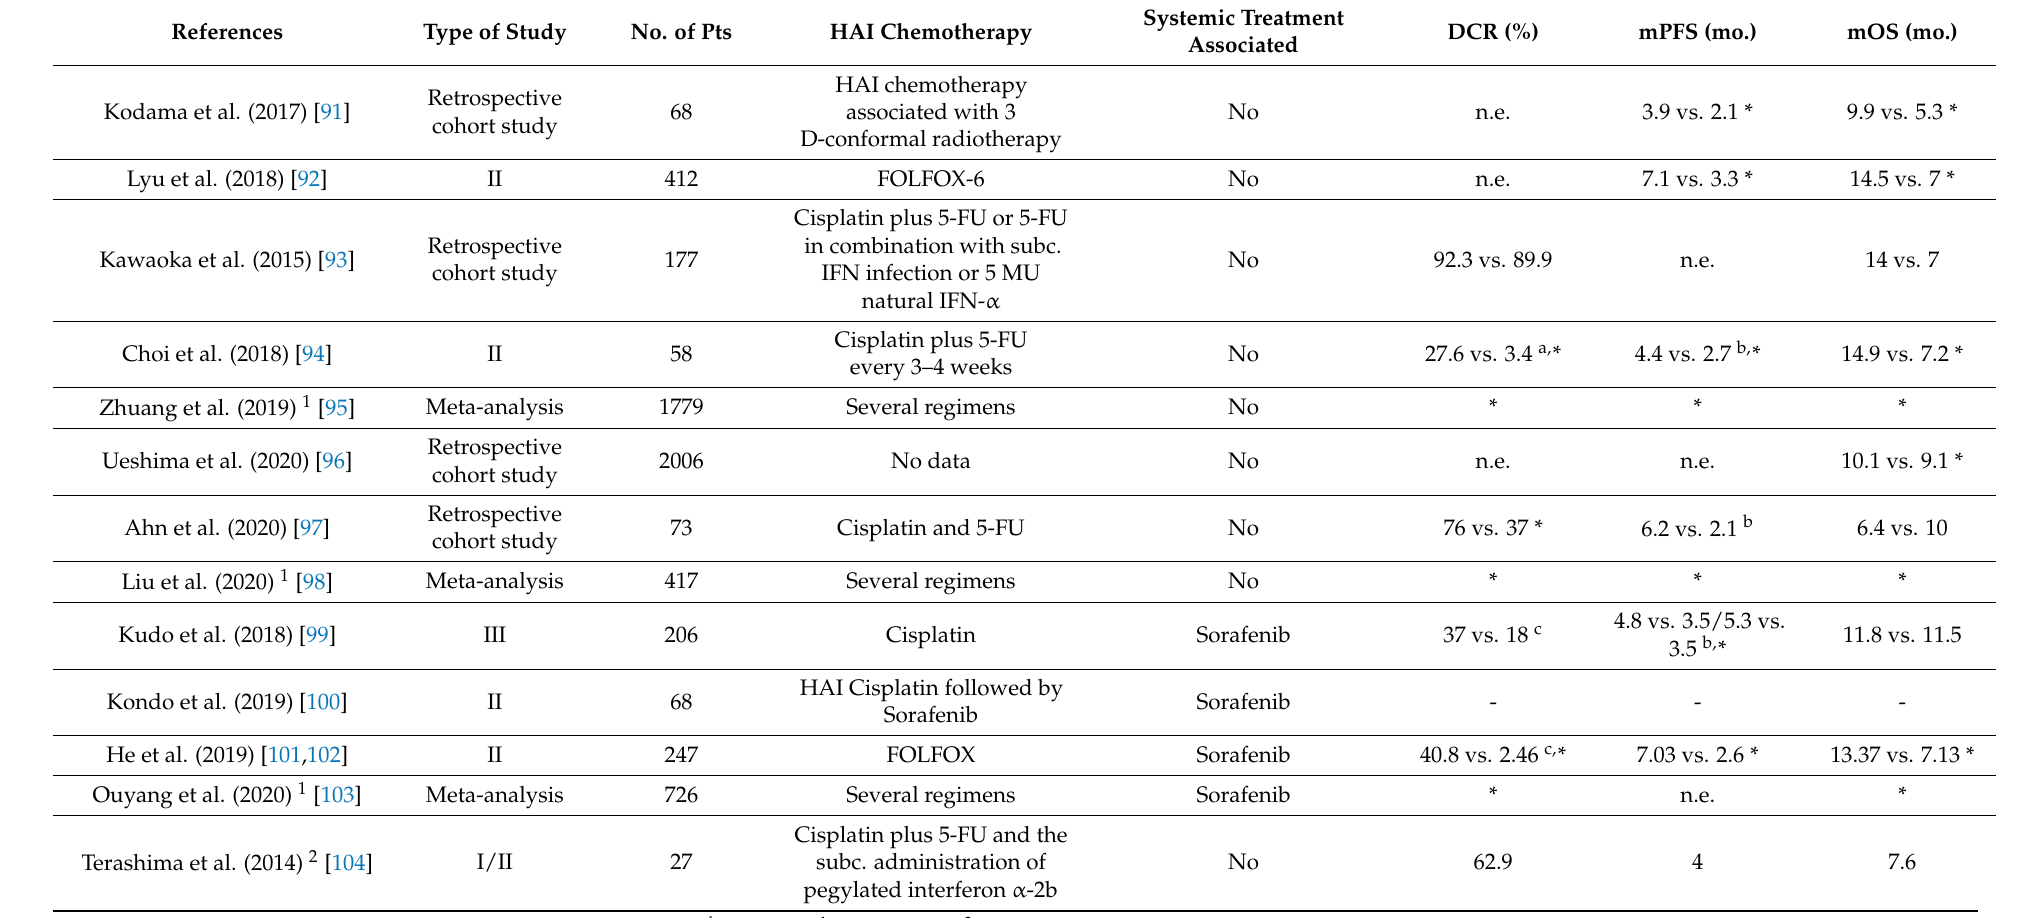
Table 4. Compilation of references included in the review of literature that evaluated HAI chemotherapy in patients with advanced